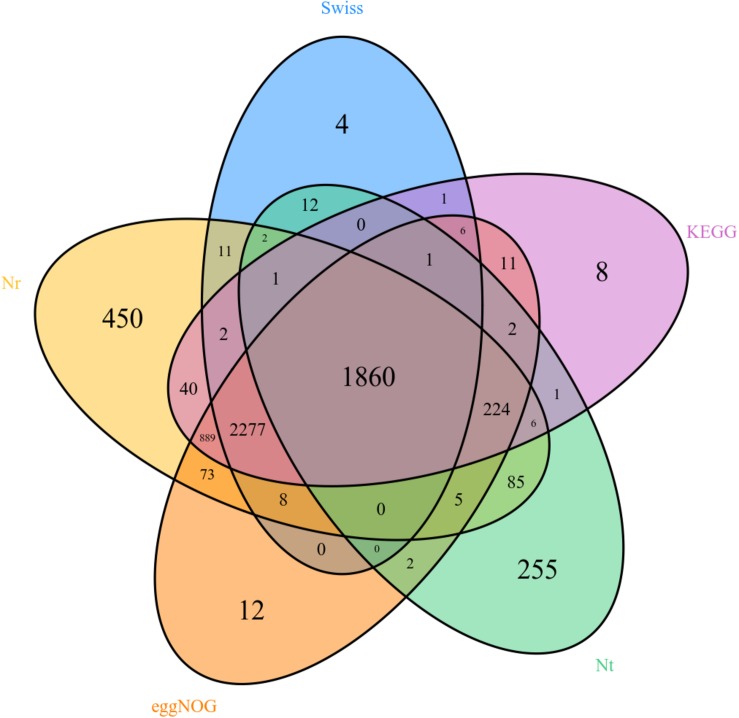
Venn diagram of comparison results of Nr, Nt, eggNOG, and Swissprot.